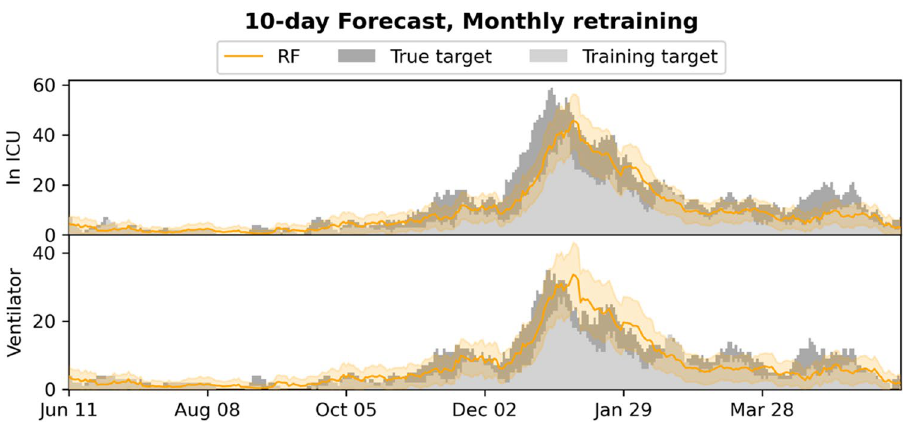
Figure 4. 10-day forecasts of admission to ICU and use of mechanical ventilation, compared to the training and true targets in the monthly retrained setting. The estimated 95% confidence intervals are